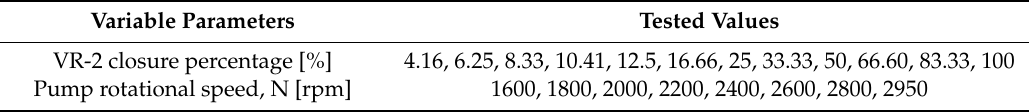
Table 2. Experimental tests specifications.